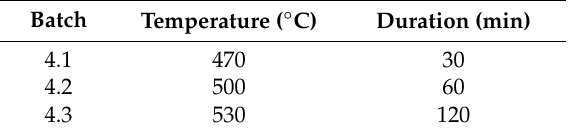
Table 2. List of plasma nitriding parameters applied for the treatment of specimens.